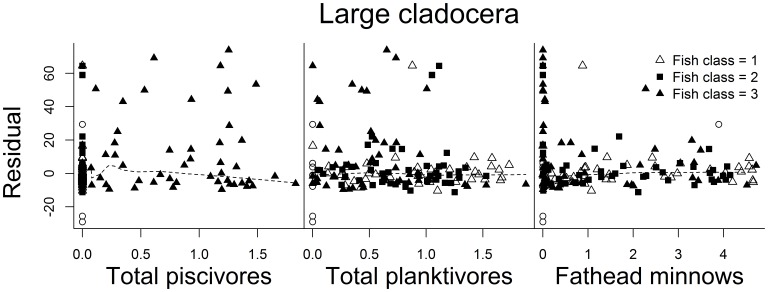
Relationships between large cladoceran model predictions and fish communities in study lakes.Residual values from the large cladoceran model versus relative abundance (mass) of total piscivores, total planktivores, and fathead minnows. Lines depict smooth trends estimated using the “lowess” function in program R. Symbol depicts fish class or fish feeding guild present in lakes (0 =  fishless, 1 = planktivores only, 2 = planktivores and benthivores, 3 = planktivores, benthivores, and piscivores).